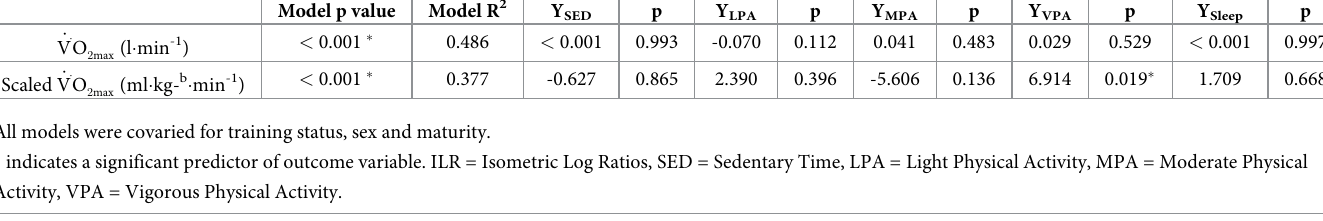
Table 4. Model ILR parameters for _ V _ O